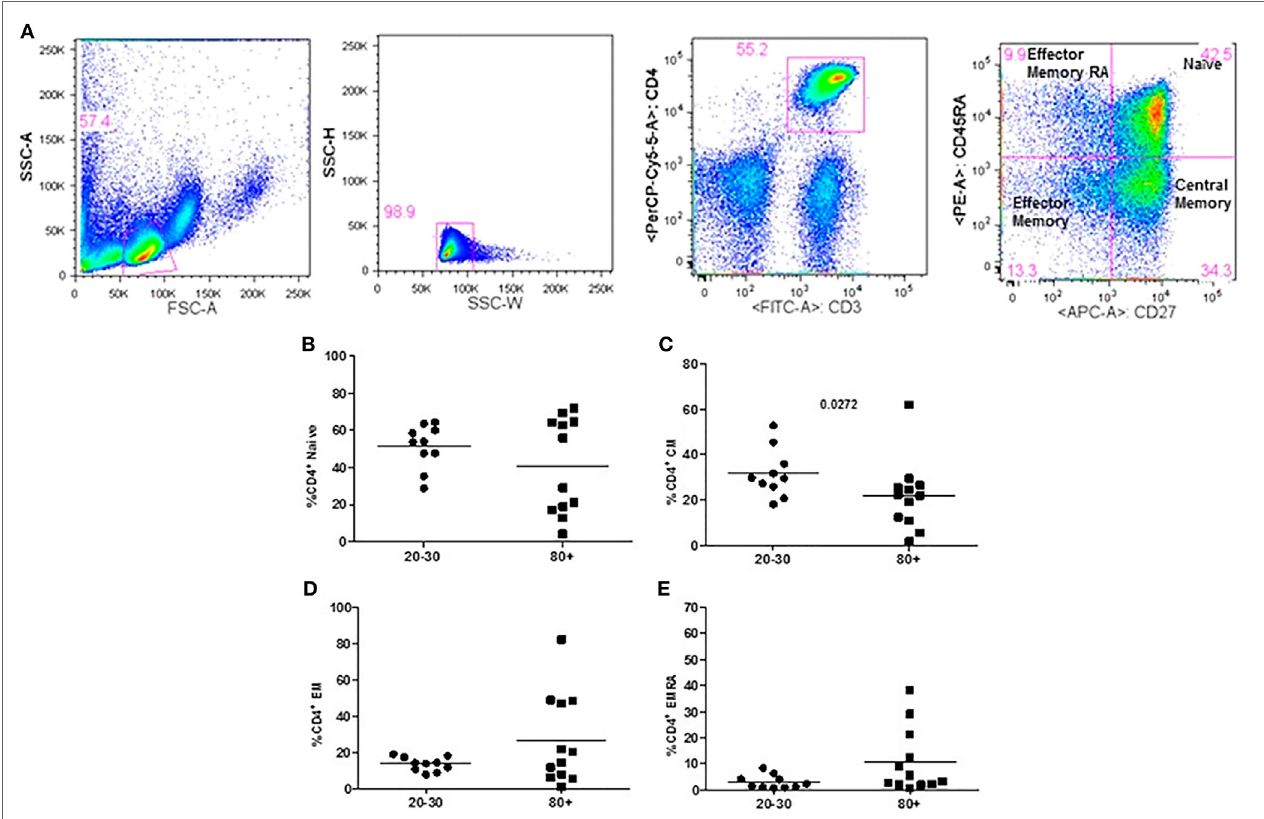
FigUre 3 | Representative flow cytometry plots showing gate strategy for the frequency of CD4 + T cells phenotype. Gate in live lymphocytes (FSC-A × SSC-A), doublets exclusion (SSC-H × SSC-W), gate in CD3 + CD4 + T cells, gate in CD45RA + CD27 + (Naïve) T cells, gate in CD45RA − CD27 + (central memory) T cells, gate in CD45RA − CD27 − (effector memory), gate in CD45RA + CD27 − (effector memory re-expressing CD45RA) T cells (a) . Percentage (%) of CD4 + T cells phenotypes: Naïve (b) , central memory (c) , effector memory (D) , effector memory RA re-expressing CD45RA (e) in 20–30 and 80 + years old